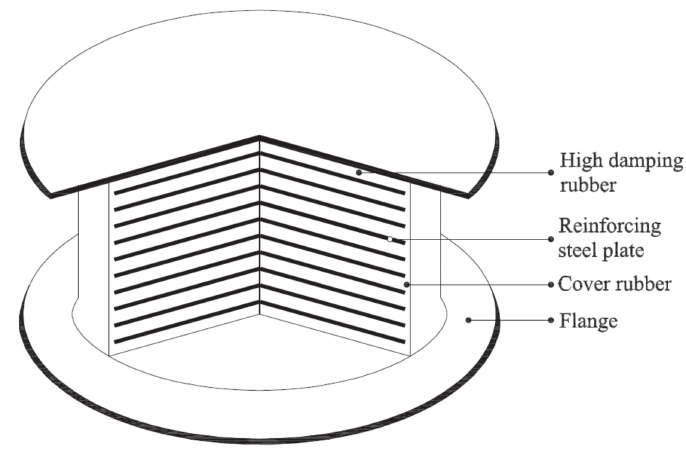
Figure 3. Cross-section of high-damping rubber isolation bearing [13].